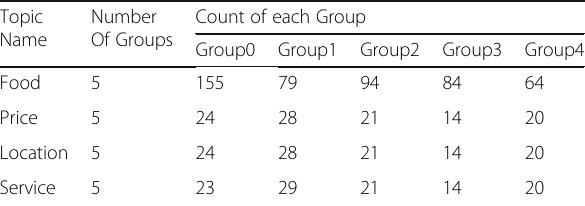
Table 4 Performance of LTAGD in terms of memory